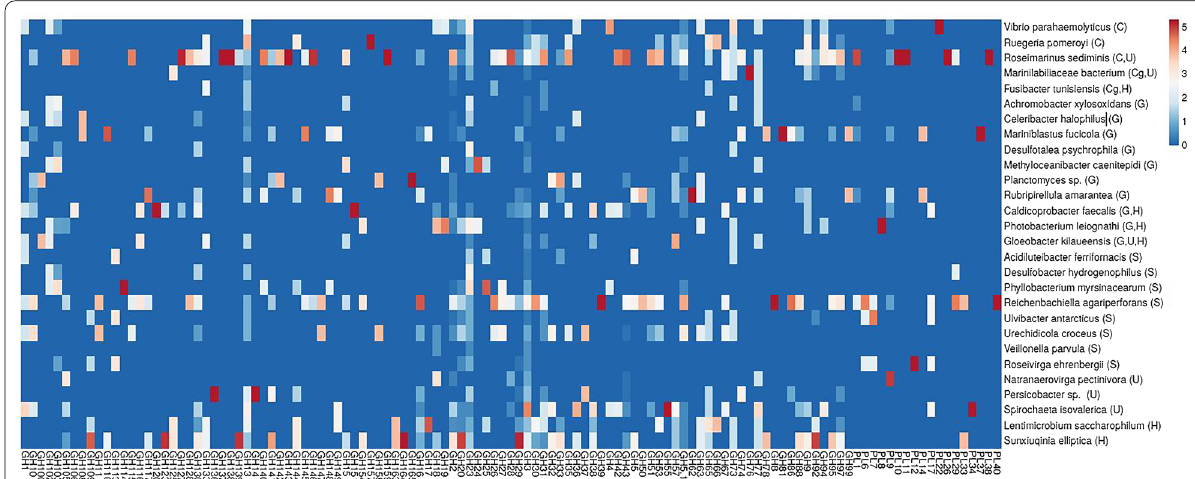
Fig. 6 A heatmap diagram of the variation in content and number of copies of glycoside hydrolase (EC 3.2.1.‑) and polysaccharide lyase (EC 4.2.2.‑) genes in the genome of the identified key microbes that fell into the determination of core (C), core‑generalist (Cg), generalist (G), specialist (S), or unique (U) microbes, and the keystone hub microbes in the microbial networks